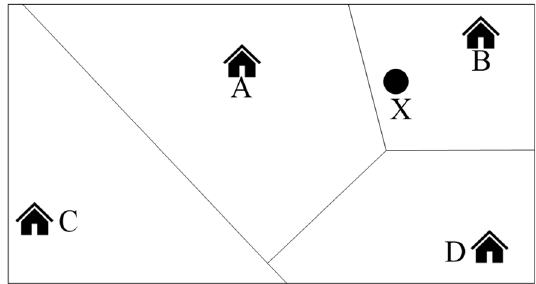
Figure 8. Basic sub-region according to Voronoi diagram where dot represents the home of citizen x and each small house is a dispatch station.